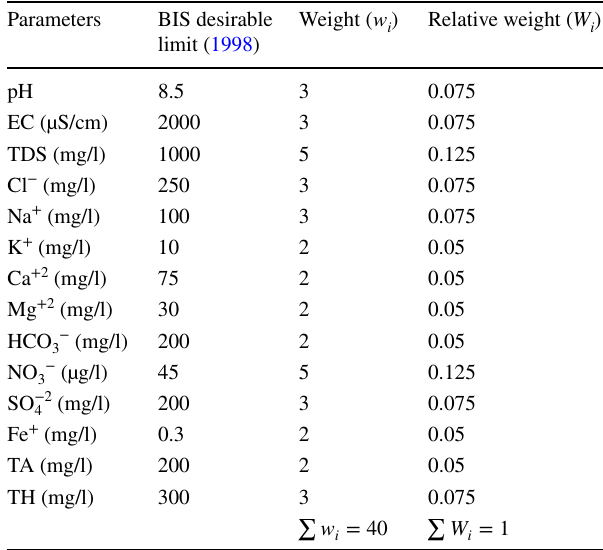
Table 3 The weight and relative weight of physical and chemical parameters (Ravikumar et al. 2013)